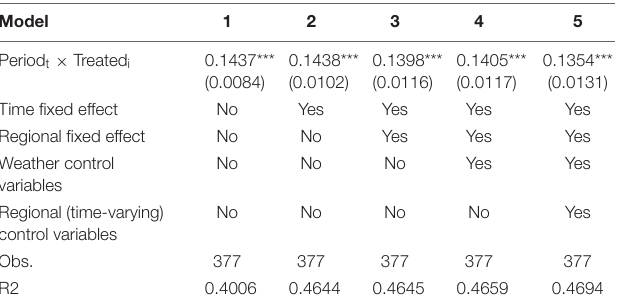
TABLE 3 | Influence of the raw milk purchase guide price policy on the product price index. Model